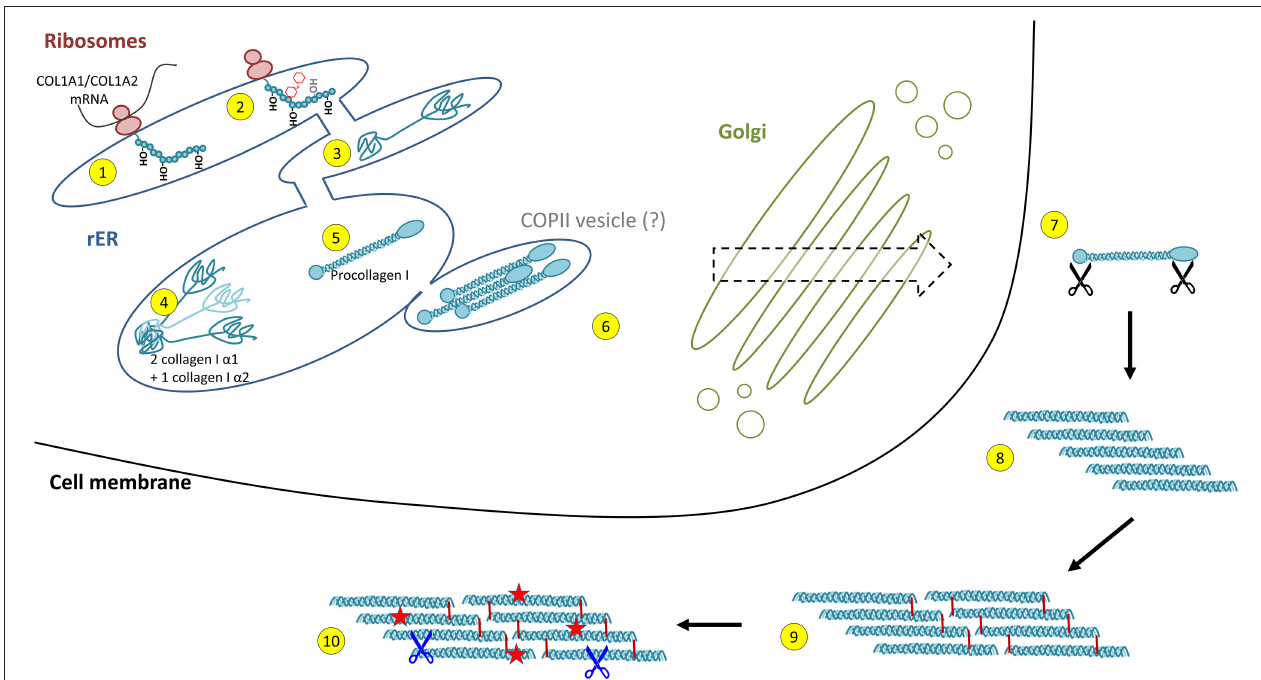
FIGURE 2 | Intracellular collagen biosynthesis and extracellular maturation of collagen I. (1) Cotranslational prolyl-4- and lysyl-hydroxylation of the nascent collagen polypeptide chain in the rough endoplasmic reticulum (rER) is followed by (2) glycosylation and prolyl-3-hydroxylation and (3) folding of the C- and N-terminal propeptides. (4) For collagen I, two properly folded α 1 chain C-propeptides assemble with one α 2 chain C-propeptide, forming the triple helix nucleus. (5) Triple helix formation occurs in a zipper-like fashion and is dependent on peptidyl-prolyl isomerases and collagen chaperones. (6) Collagen triple helices are transported via the trans-Golgi network and finally secreted into the extracellular space. This was believed to occur via COPII vesicles, a concept that has been challenged recently. (7) In the extracellular space, propeptide cleavage involving at least three proteases (black scissors) triggers (8) auto-assembly of collagen fibrils. (9) Finally, fibrils are stabilised by crosslinking. (10) The mature collagen fibres are subject to insults (red stars) and degradation by extracellular proteases (blue scissors, see Figure 4 ).